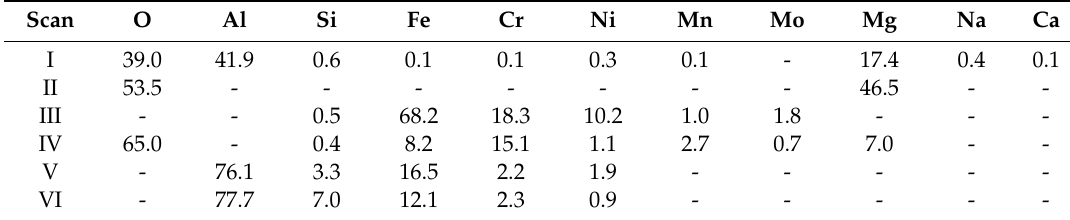
Table 11. Results of EDS scans corresponding with areas indicated by arrows in Figure 12 (in at %).